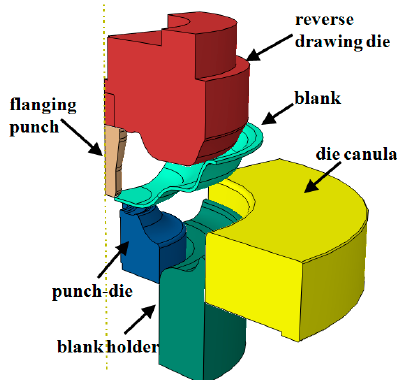
Figure 3. Geometry models of blank and dies of the reverse drawing–flanging process of B550CL spoke.